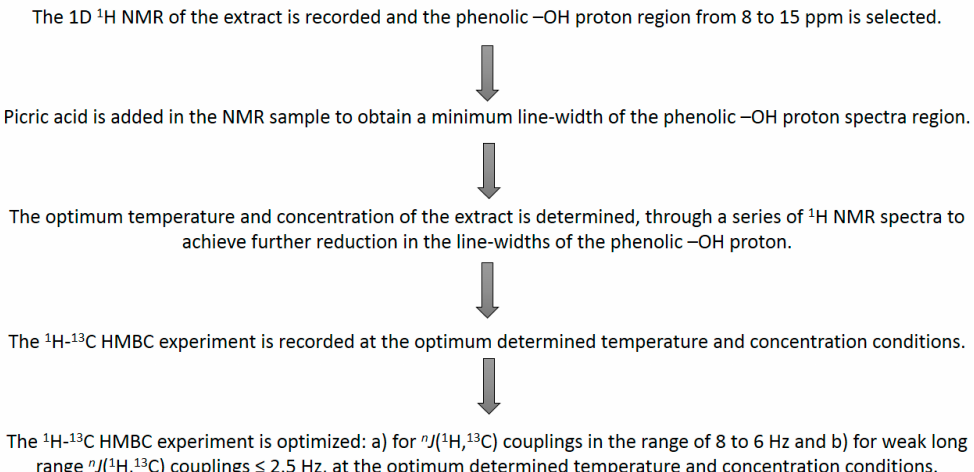
Scheme 2. Experimental protocol for sequential and carbon resonance assignments [16].